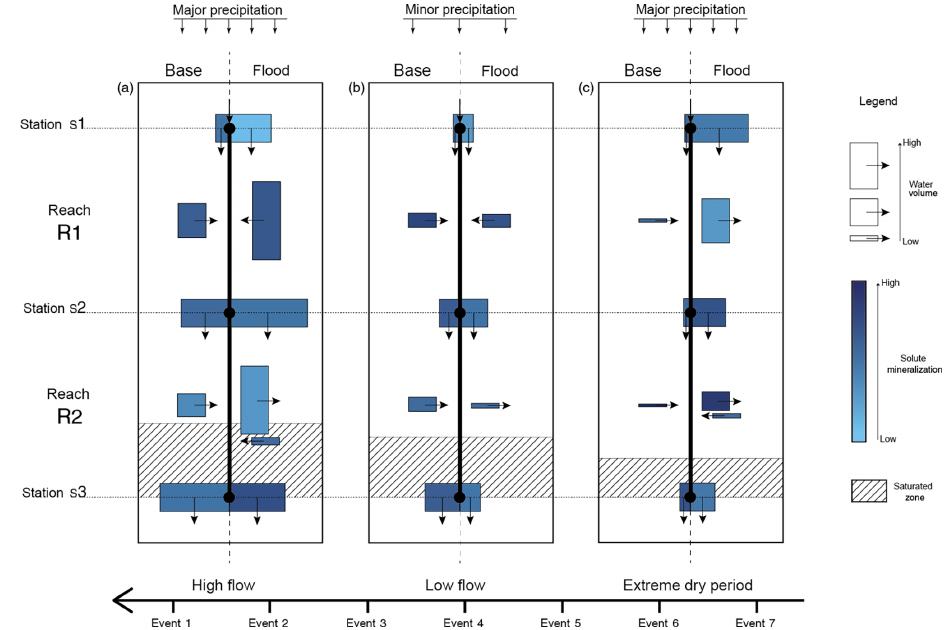
Figure 10. Hydrogeological functioning scheme of the Fourbanne karst aquifer, showing the contributions of lateral exchanges in terms of volume and mineralization for three hydrological conditions. For each graph, the representation of the lateral exchanges along the reaches (vertical black line) distinguishes the base component (left size) and the flood component (right